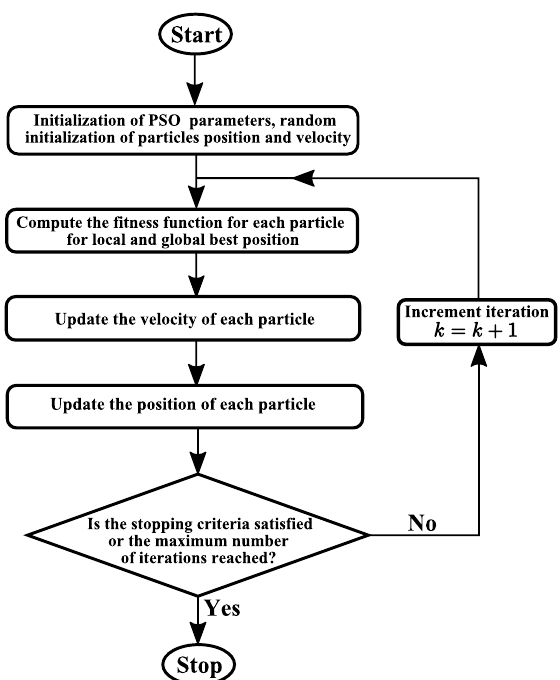
Figure 8. Particle swarm optimization flow